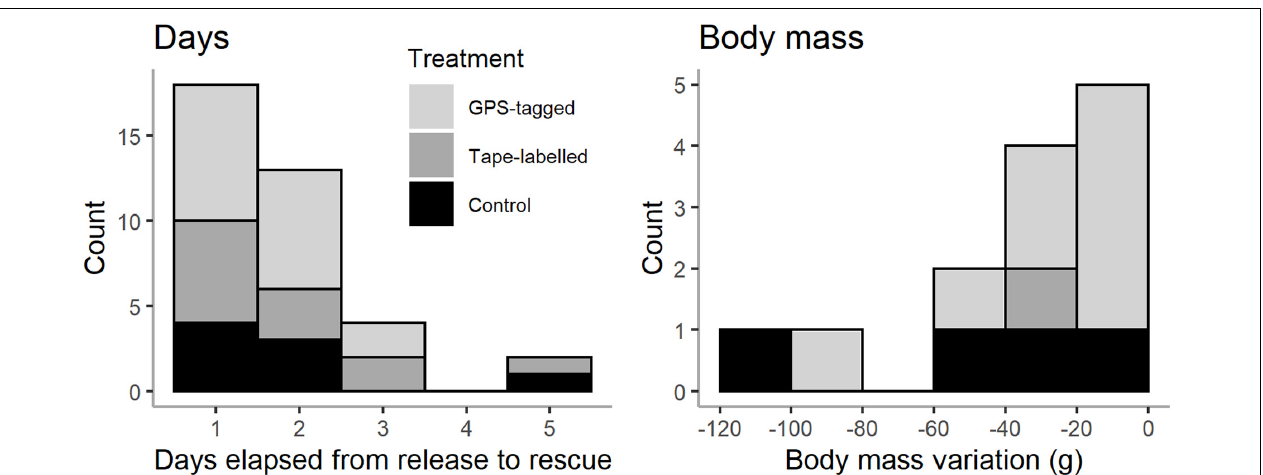
models, flight straightness was related to environmental light levels. Flights were more tortuous with high light pollution levels, but straightness increased with moon luminance ( Table 5 and Figure 3 ).